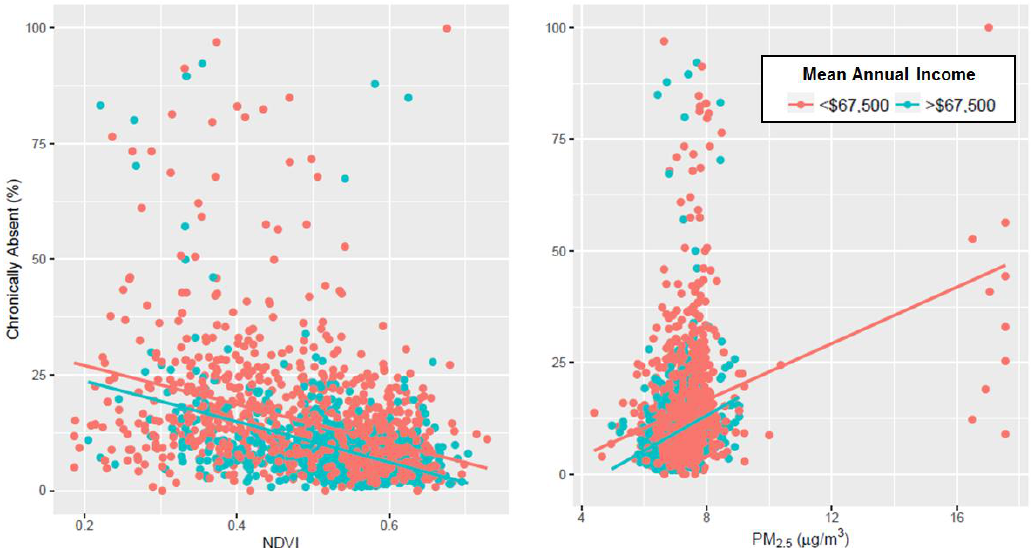
Figure 2. Relationship between NDVI and PM 2.5 on the percent of students chronically absent during the 2012–2013 academic year at each school in Massachusetts (USA), stratified by counties with a mean annual income above and below